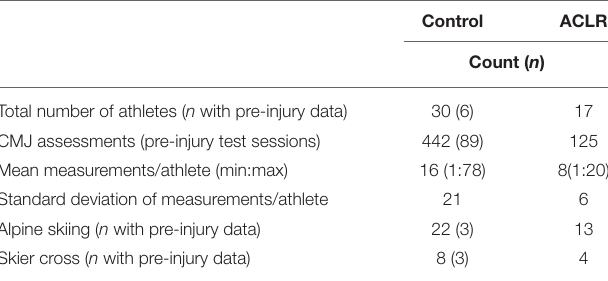
TABLE 1 | Breakdown of measurement count and sample size by sport (countermovement jump–CMJ, anterior cruciate ligament reconstruction–ACLR, non-injured controls, min:max–the minimum and maximum number of CMJ tests per